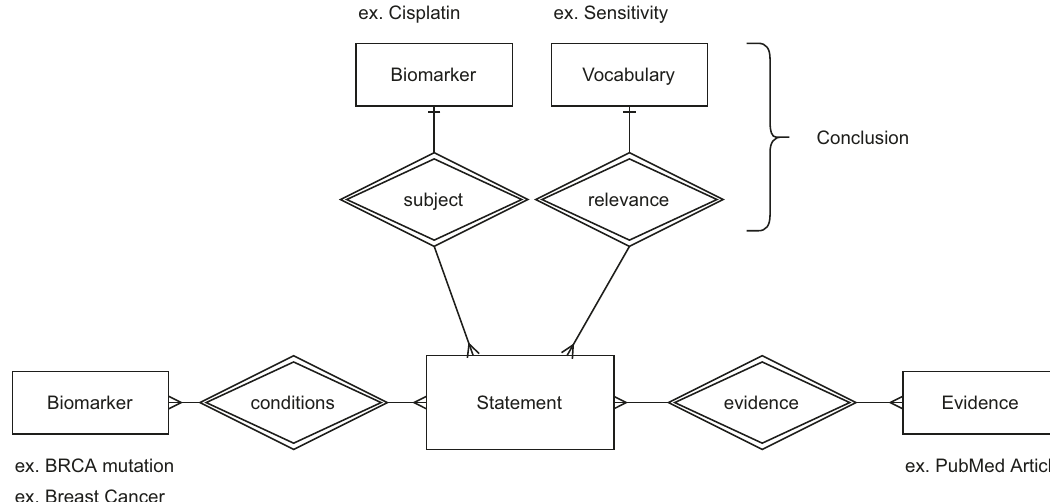
Fig. 3 GraphKB Statement Schema. Statements are composed of four main elements: conditions, subject, relevance, and evidence. A statement may be linked to any number of conditions but only one subject and relevance. The conclusion of a statement is considered to be composed only of the relevance and subject.